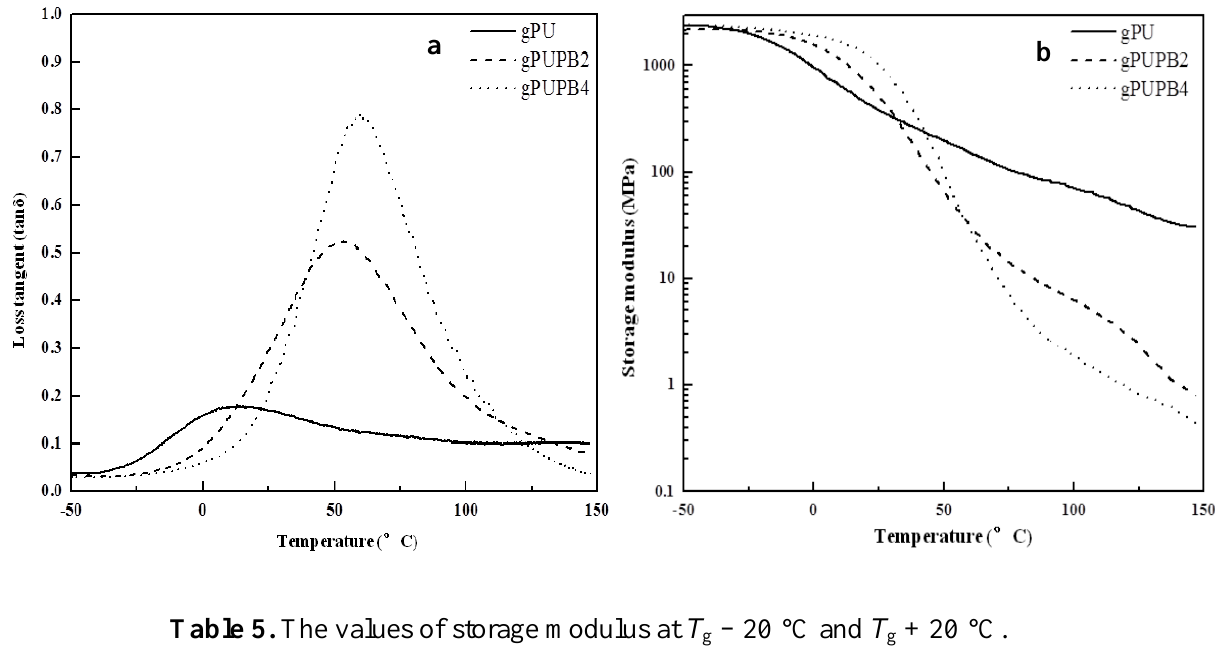
Table 5. The values of storage modulus at T